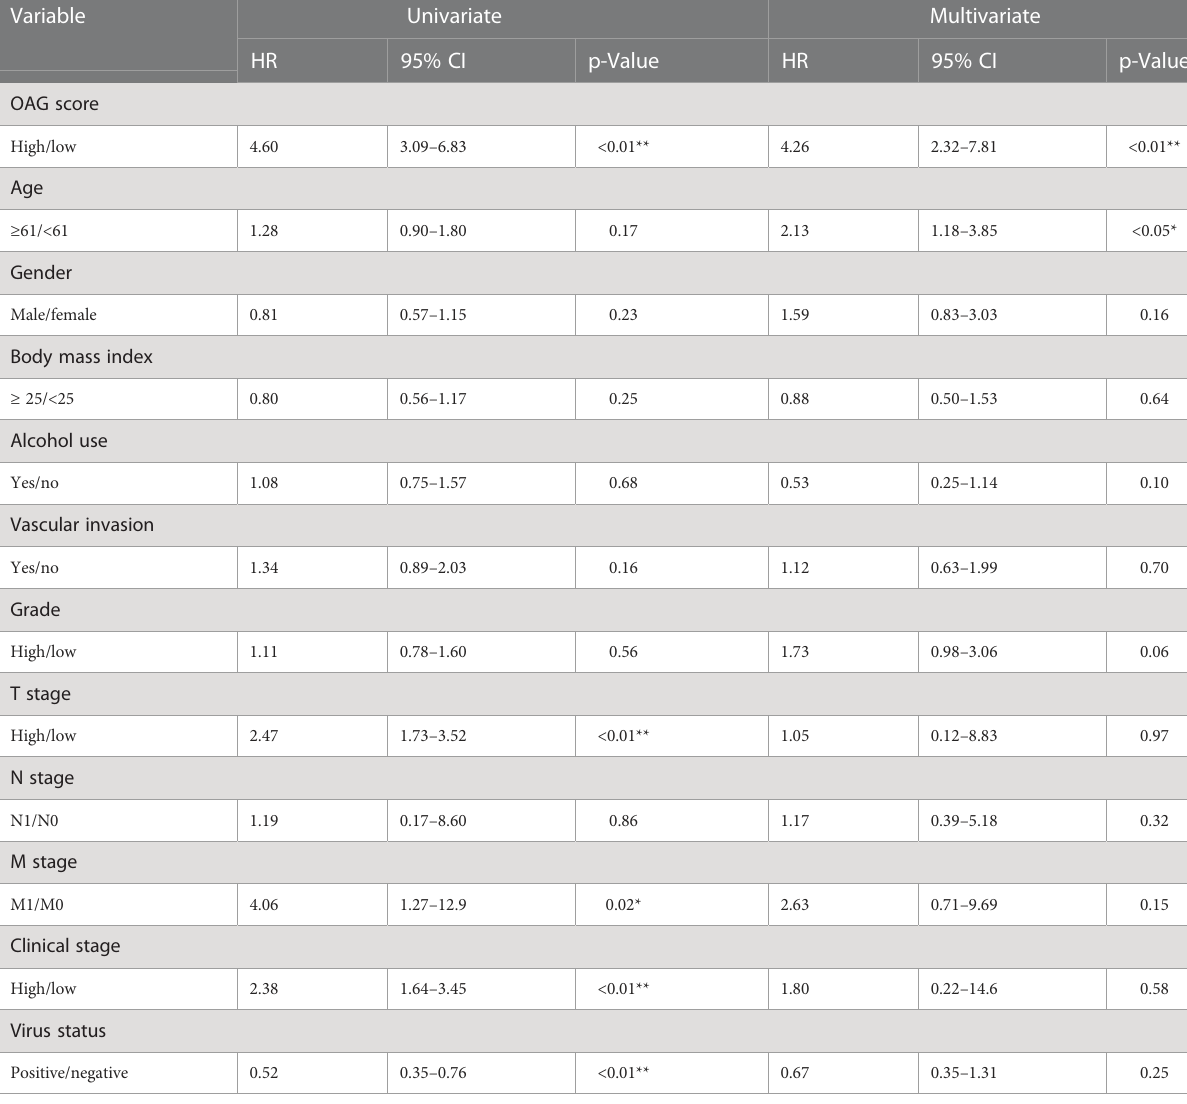
TABLE 3 Univariate and multivariate Cox regression analyses for OAG score and clinical features in TCGA-HCC